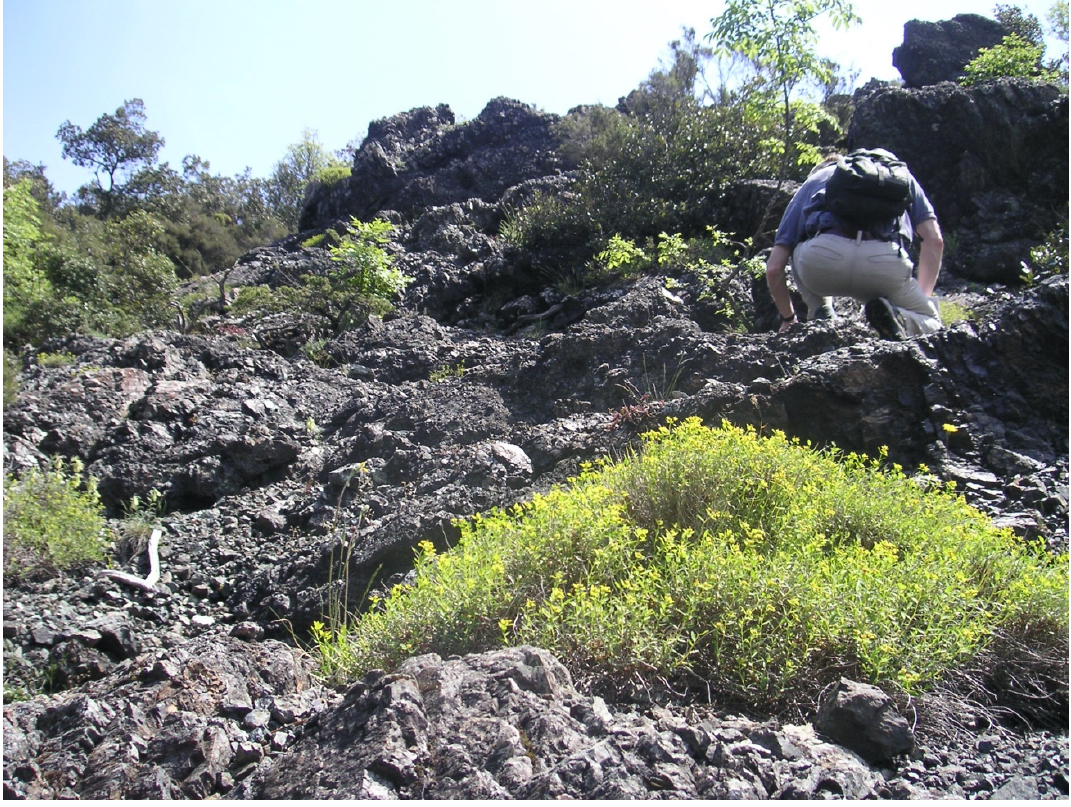
Figure 2. Alyssum bertolonii growing on serpentine rock, Upper Tiber Valley, Tuscany, Italy (Photo: D. Fernando 2006).